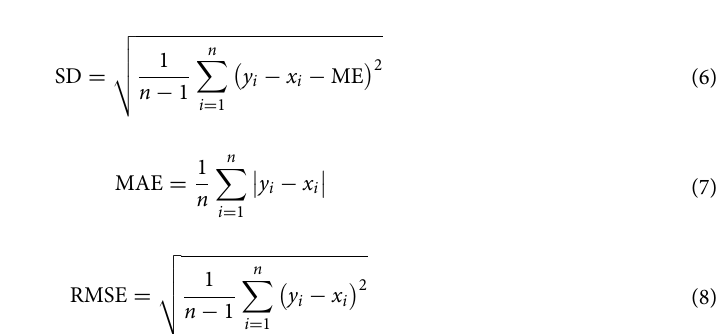
Figure 3. The correlation coefficients between RRI and PAT with different delays or different smoothness. ( a ) The correlation coefficients between PAT and delayed RRI for all subjects in the natural state. Delay is the delayed beats of RRI series. ( b ) The correlation coefficients between smoothed RRI and smoothed PAT for all subjects in the natural state. Window length is the window length of the Savitzky-Golay filter. If window length = 0, no